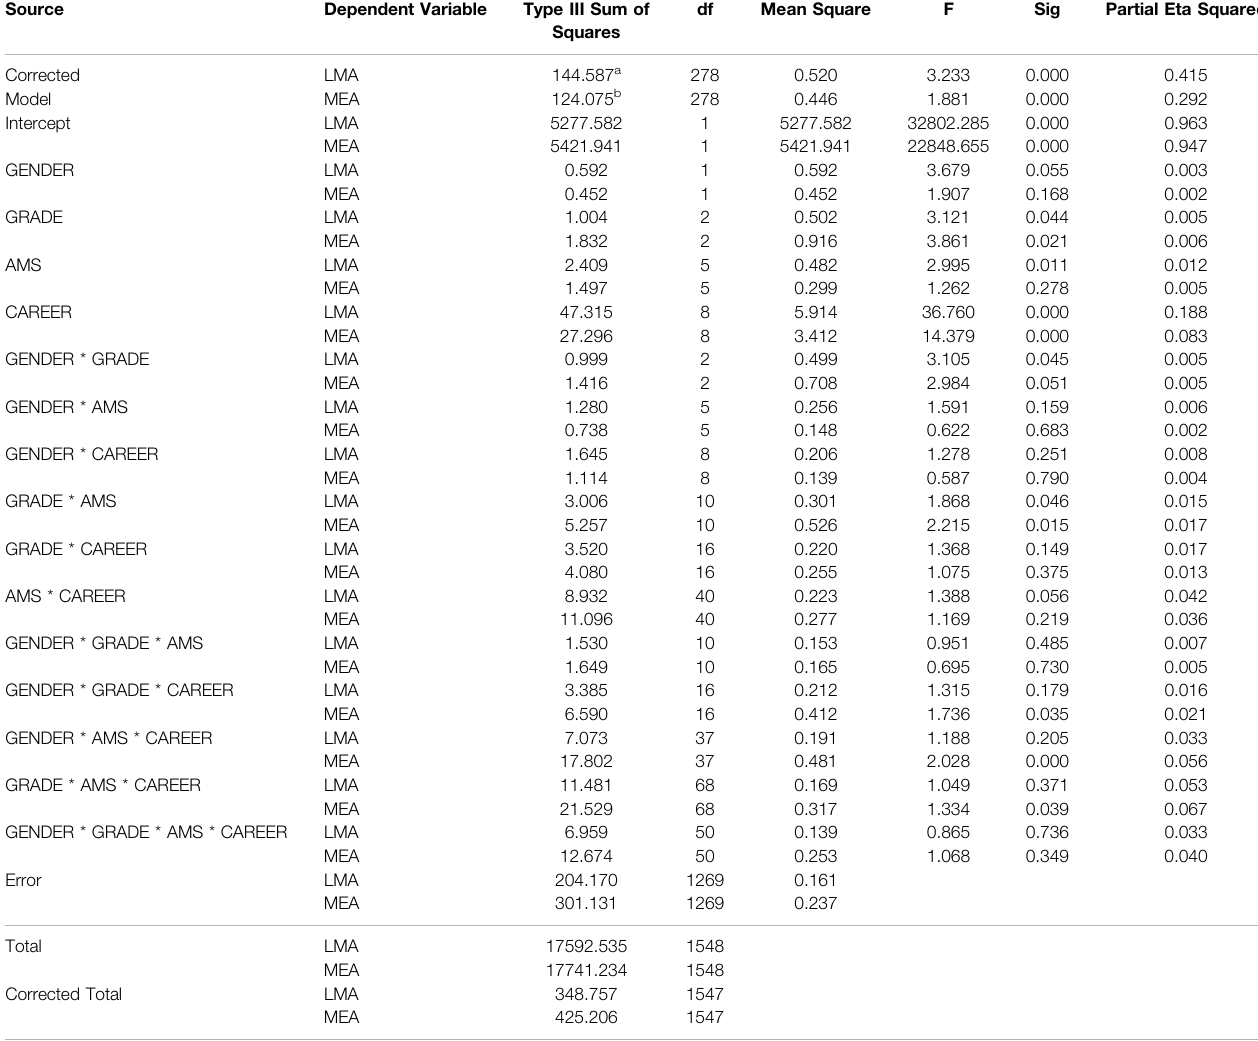
TABLE 5 | Combined univariate